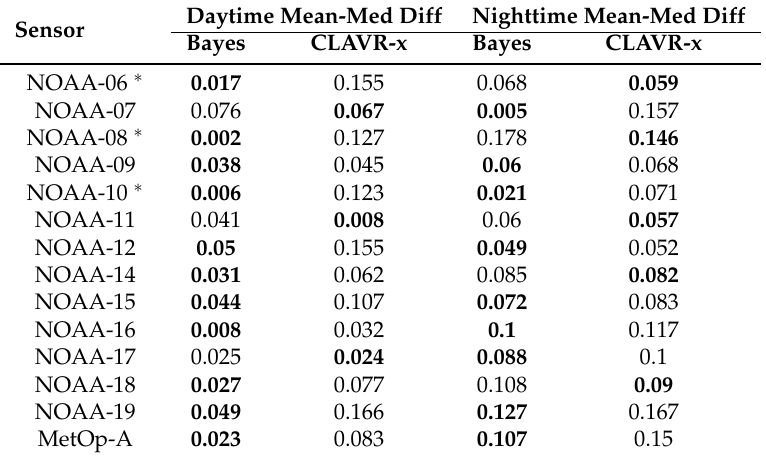
Table 10. Absolute difference between mean and median bias for two-channel (10.8 and 12 µ m) daytime and three-channel (3.7, 10.8 and 12 µ m) nighttime SST retrieval statistics using Bayesian and CLAVR-x cloud masks compared against drifting buoy